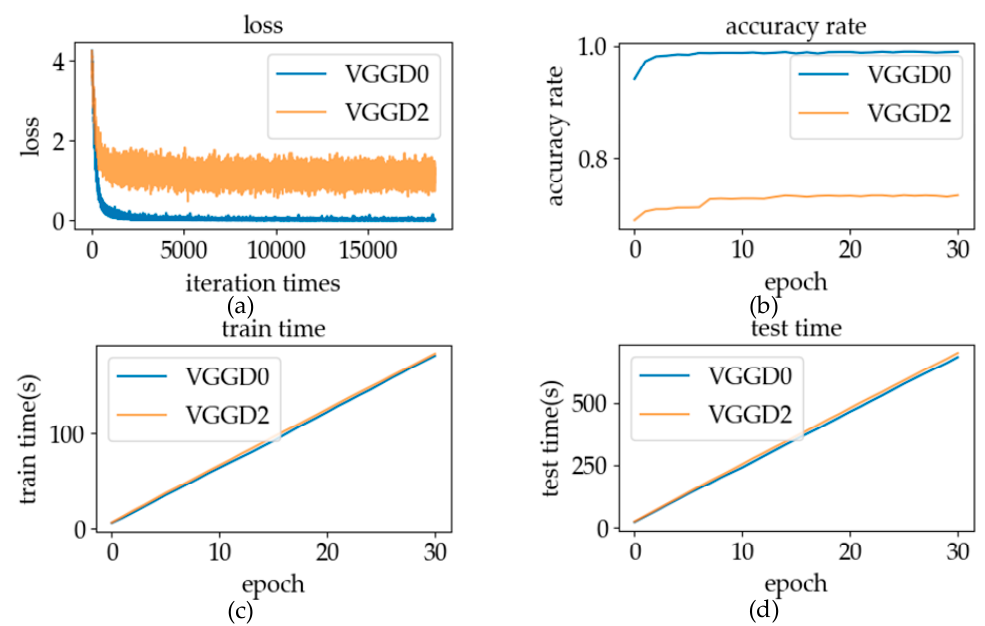
Figure 19. The compared experimental results of two different activation functions. Each subgraph in this diagram has exactly the same meaning as in Figure 18. The VGGD2 represents the use of the ReLU activation function, and the VGGD0 represents the use of the Leaky ReLU.